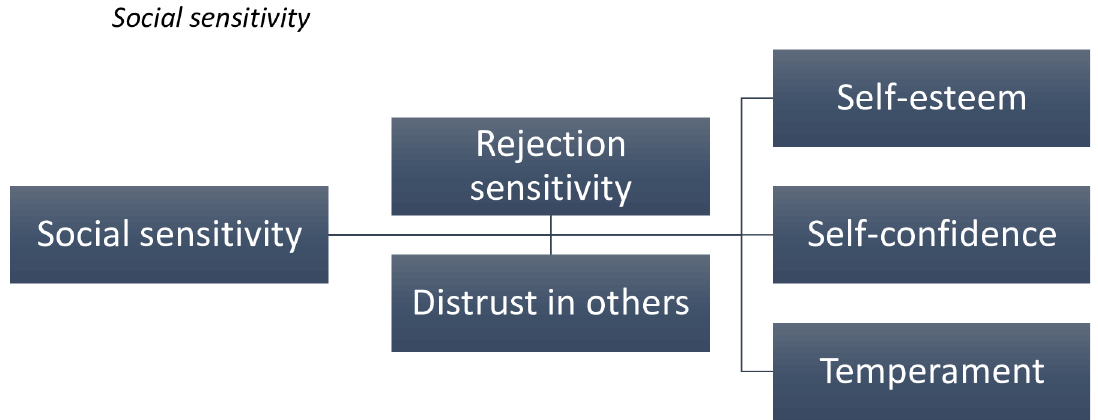
Fig 3. The furthest left hand box indicates the superordinate themes, with the subordinate themes in the remaining boxes. The connecting lines indicate the hierarchical organisation of the themes.